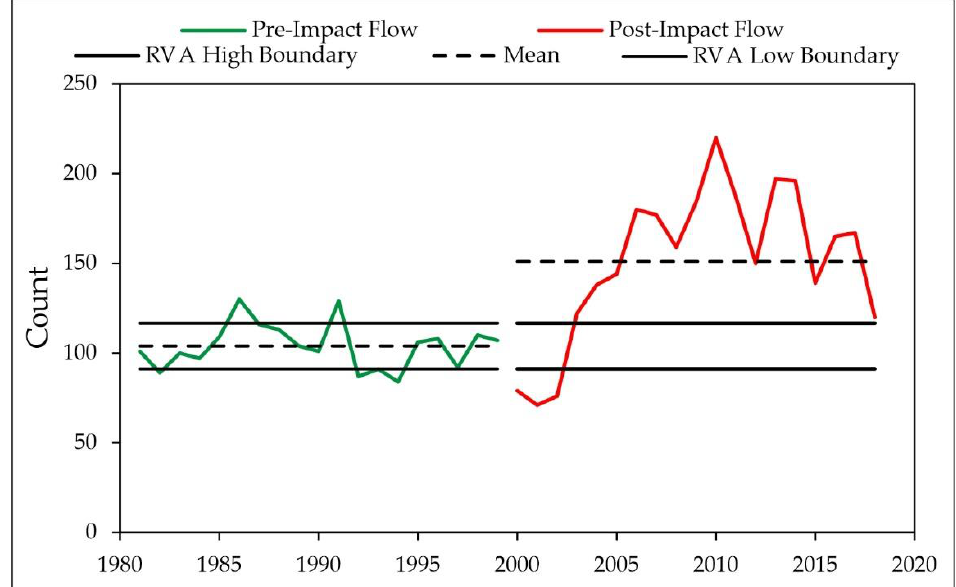
Figure 10. Hydrologic alteration of the number of reversals at Šušvė -Josvainiai WGS.